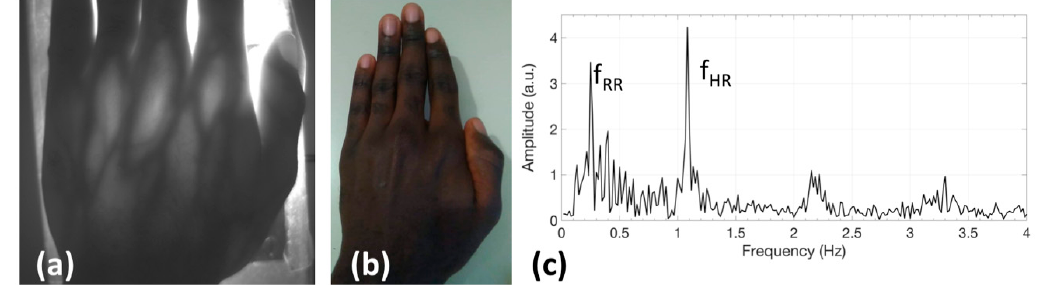
Figure 8. Results obtained on a dark-skin, male subject. ( a ) image of the hand acquired with the transillumination system (exposure time 306 ms); ( b ) photo of the hand taken with a color CMOS camera without NIR illumination and filter, to demonstrate the dark color of the skin of this subject; ( c ) signal in the frequency domain extracted from the video taken on this subject.